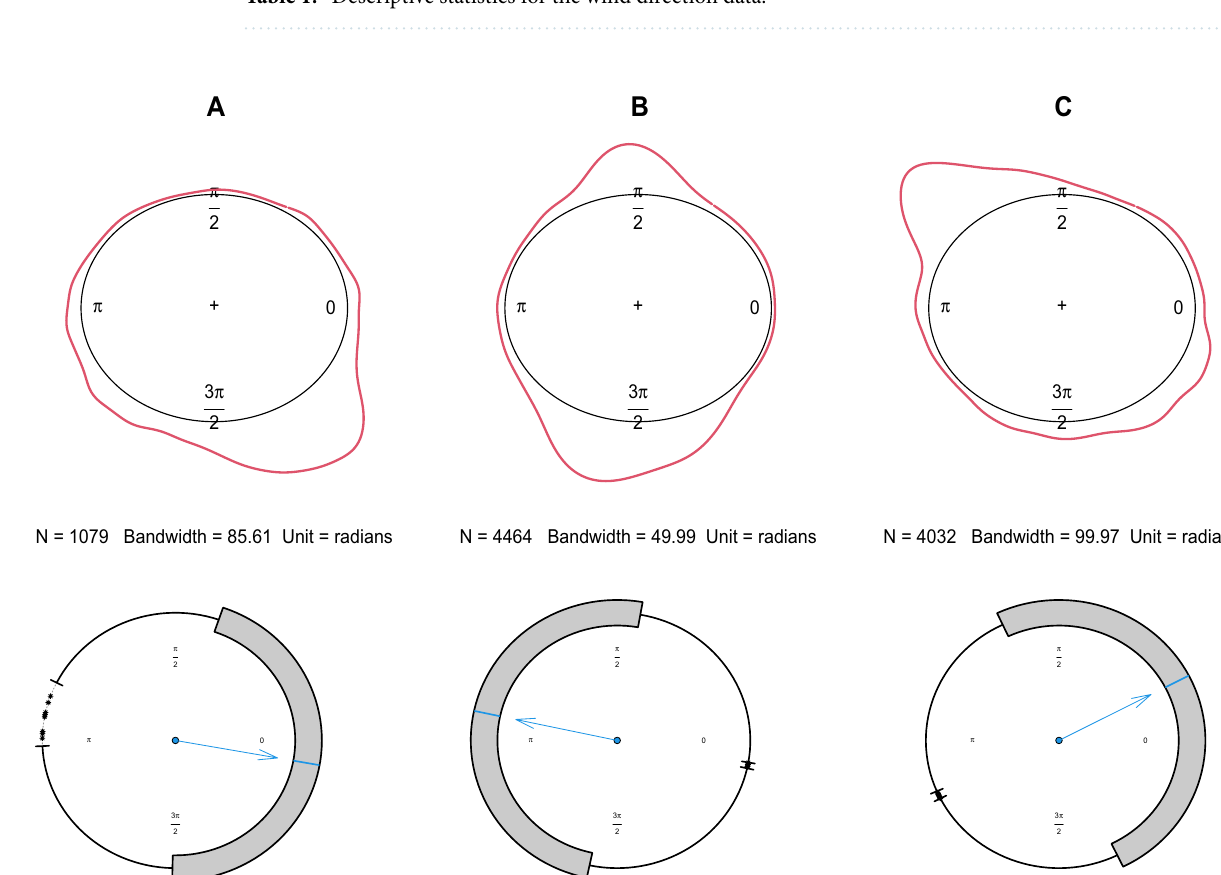
Table 1. Descriptive statistics for the wind direction data.